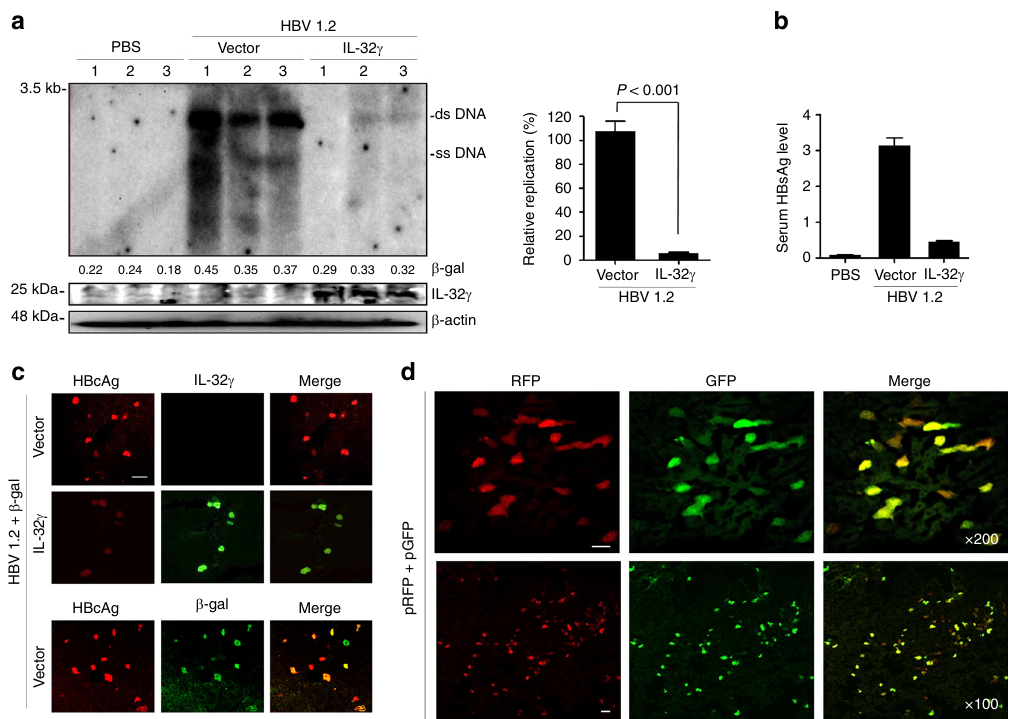
Fig. 6 IL-32 γ suppresses HBV in a mouse model. a Six-week-old male mice (3 mice per group) were killed 4 days after hydrodynamic injection of the indicated plasmids: control vector, 20 µ g; HBV 1.2, 20 µ g; β -gal, 5 µ g. HBV replication was analyzed by Southern blotting using 50 mg of liver tissues. The level of IL-32 γ and β -actin were analyzed by western blotting. b The level of secreted HBsAg in serum was measured by ELISA. c Immuno fl uorescence analysis of the HBV core, β -gal, and IL-32 γ proteins in mouse liver tissues prepared as in a . β -gal protein staining was used as a control for hydrodynamic injection. Magni fi cation, ×200; scale bar, 50 μ m. d Immuno fl uorescence analysis of the co-expression of RFP and GFP proteins in the same hepatocytes. Each plasmid (pEF1 α -RFP and pEF1 α -GFP; 10 µ g) was hydrodynamically injected into mouse liver. Sections were prepared with a tissue cryotome. Green and red fl uorescence signals were observed with an inverted fl uorescence microscope at indicated magni fi cation (scale bar, 50 μ m). Data ( a , b ) were obtained from three independent experiments (mean ± S.D.). p < 0.001 by Student ’ s t